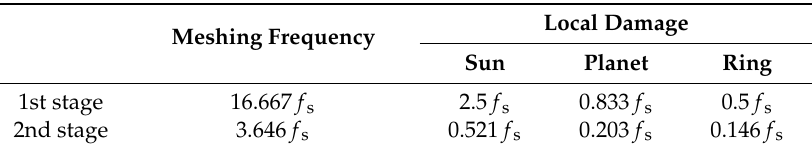
Table 2. Characteristic frequency of the planetary